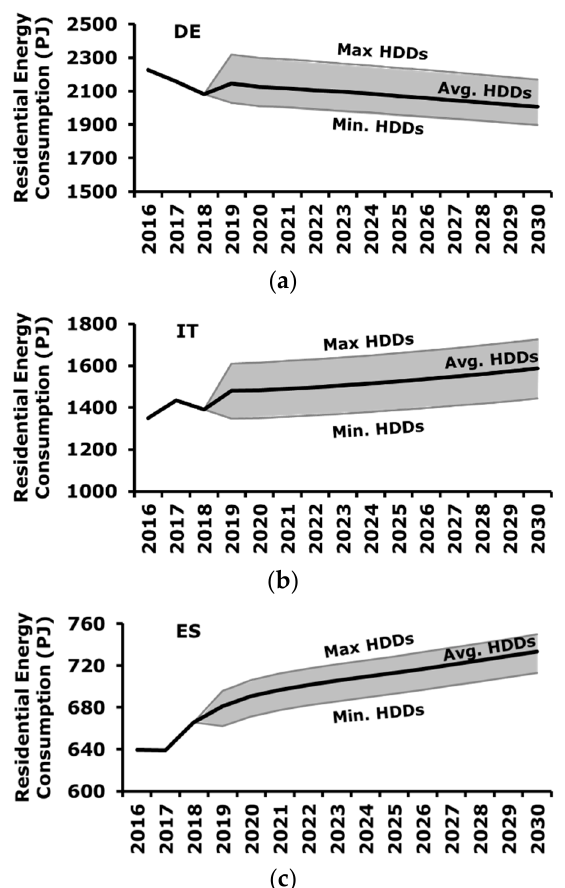
Figure 5. Forecasting of residential energy consumption for the different HDDs scenarios: ( a ) Germany: Min HDDs = 2661, Avg. HDDs = 3028, Max HDDs = 3630; ( b ) Italy: Min HDDs = 1635, Avg. HDDs = 1896, Max HDDs = 2166; ( c ) Spain: Min HDDs = 1563, Avg. HDDs = 1781, Max HDDs = 1972.